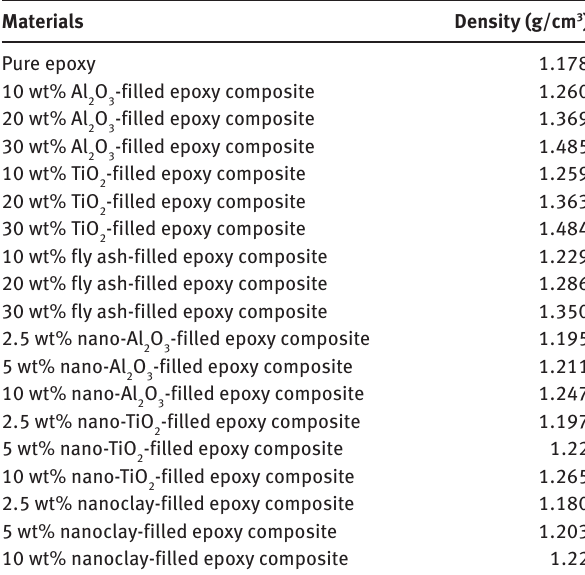
Table 2: Density of materials used.